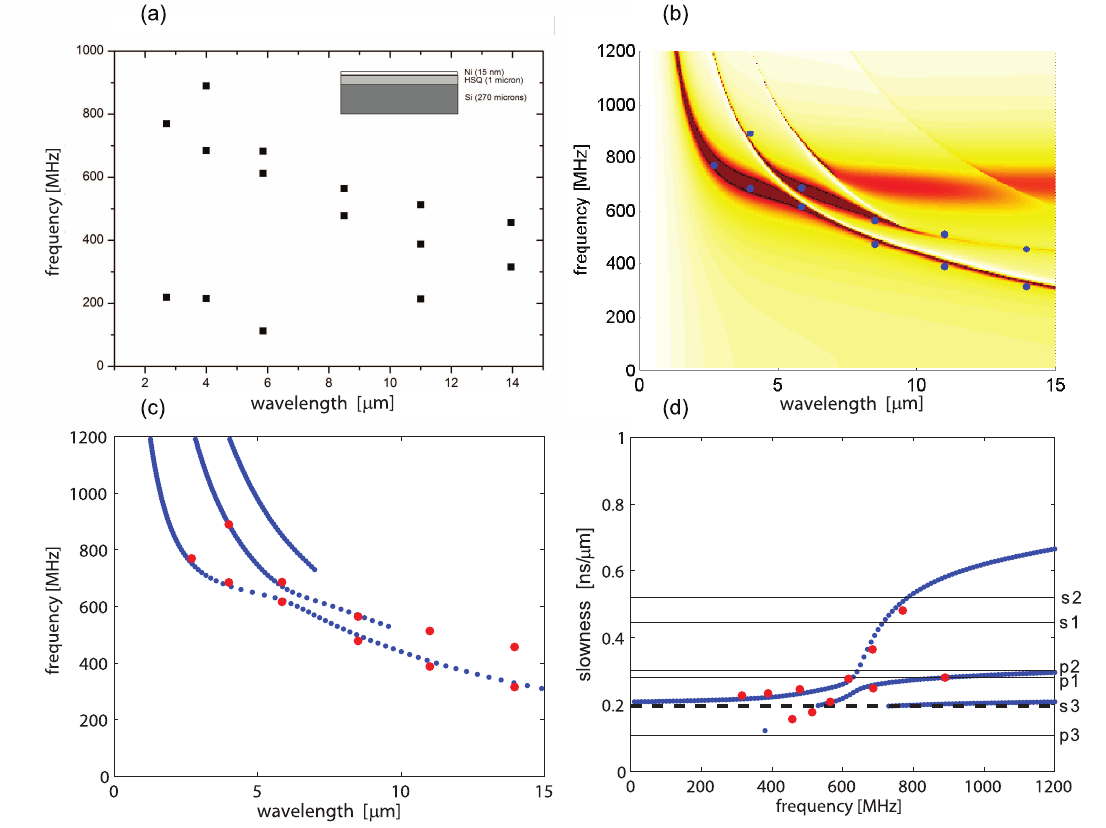
Figure 7. Second validating example for the sample Ni/HSQ400/Si without NWs. Experimental points in the ( Λ , f ) plane ( a ); | K 33 ( Λ , f ) leve-line image ( b ); SAW dispersion curves and experimental points (bold dots) in the ( Λ , f ) and frequency-slowness planes ( c , d ); low-frequency markers ( f < 250 MHz) in part ( a ) are hardware